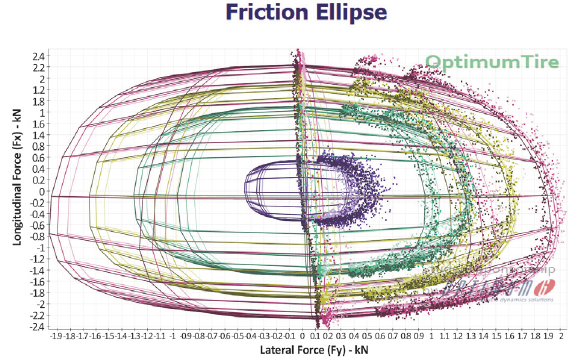
Figure 7: Friction